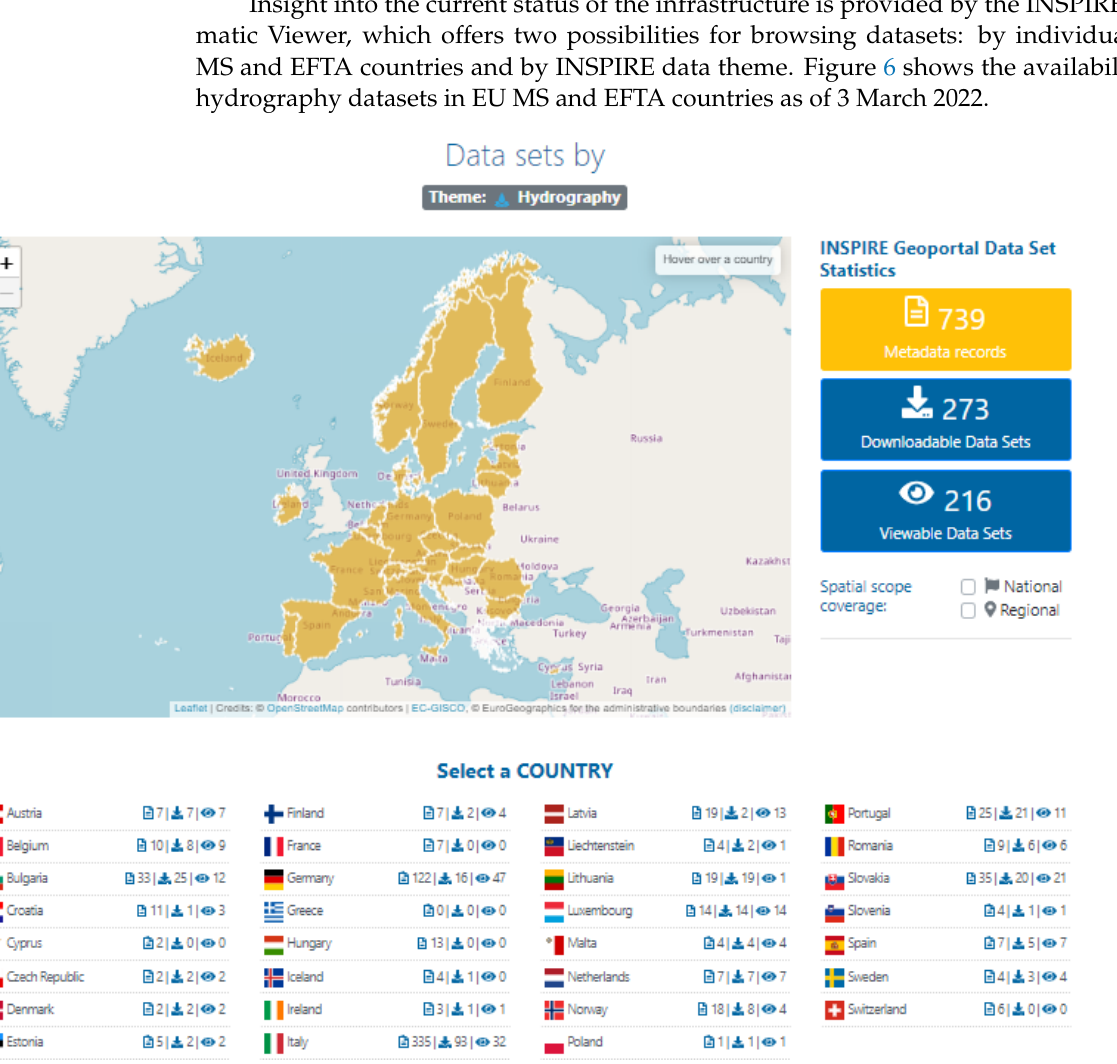
Figure 6. Available hydrography datasets in EU MS and EFTA countries. Source: European Commis- sion, Joint Research